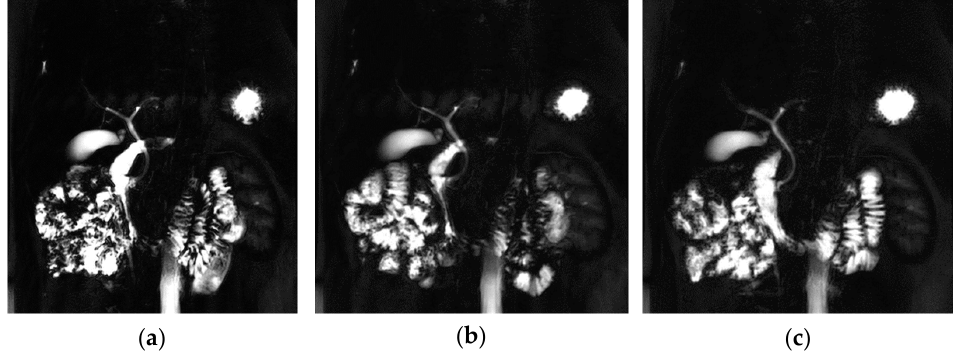
Figure 5. Coronal MRCP Maximum Intensify Projection (MIP) images with RT-2D-CS TSE sequence ( a ), RT-2D-SENSE TSE sequence ( b ), and BH-2D-SSh TSE sequence ( c ) images.